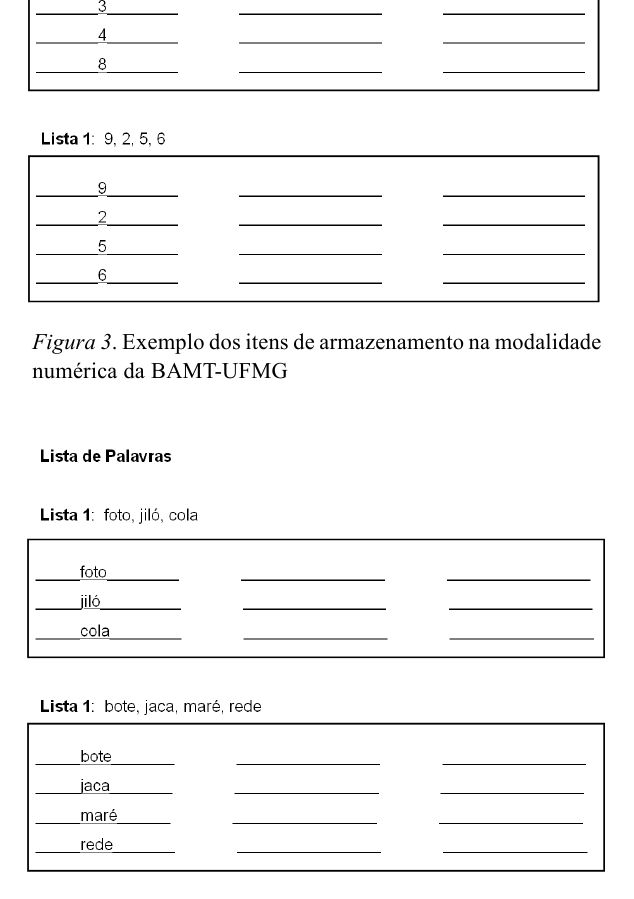
Figura 4 . Exemplo dos itens de armazenamento na